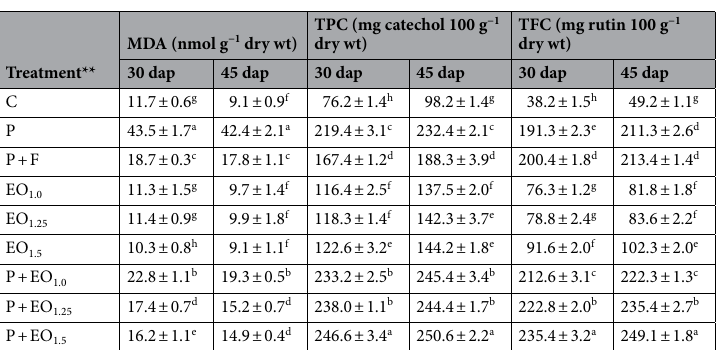
Table 6. Lipid peroxidation, total phenolic and flavonoid contents in sorghum plants infected with Fusarium solani in response to treatment with lavender essential oil at different concentrations. Values followed by the same letter are not significantly different according to Duncan’s multiple range test ( P ≤ 0.05), each value represents the mean of 3 replicates ± SD. **MDA: malondialdehyde, TPC: total phenolic content, TFC: Total flavonoid content, C: untreated control, P: infected with F. solani , P + F: infected with F. solani and treated with chemical fungicide (Rhizolex-T), EO 1.0 , EO 1.25 , EO 1.5 : treated with lavender EO at 1.0, 1.25, and 1.5% respectively, P +